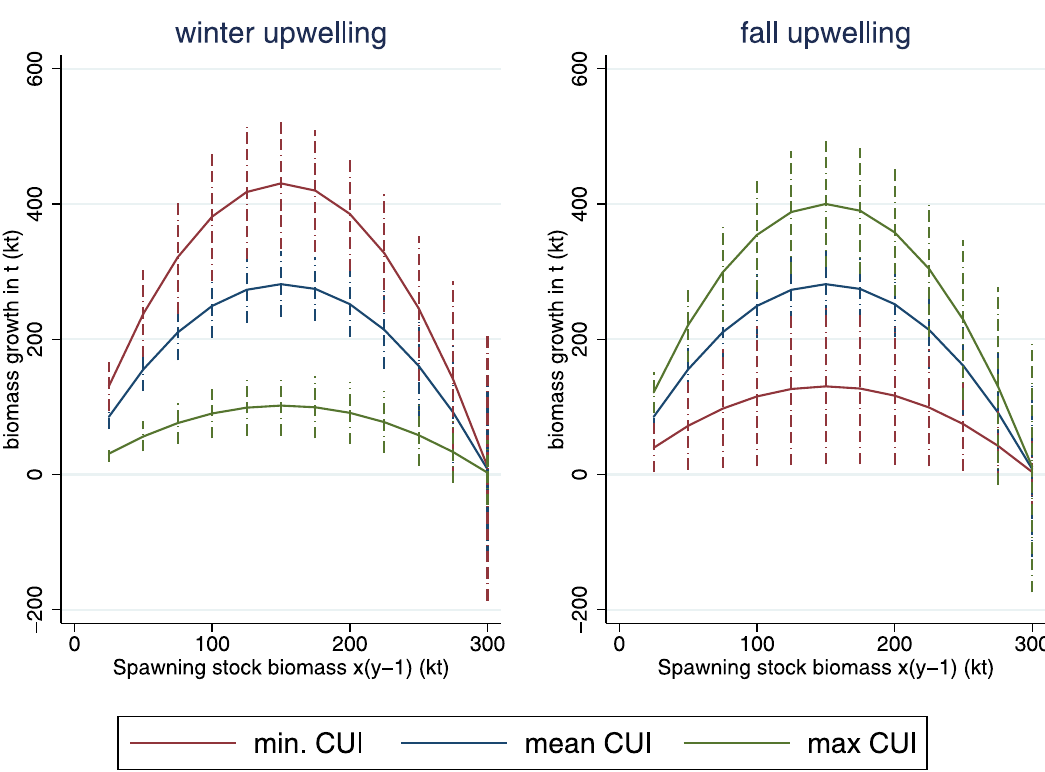
Fig 1. Sensitivity of biomass growth to a simultaneous variation of SSB ( x confidence interval variation.